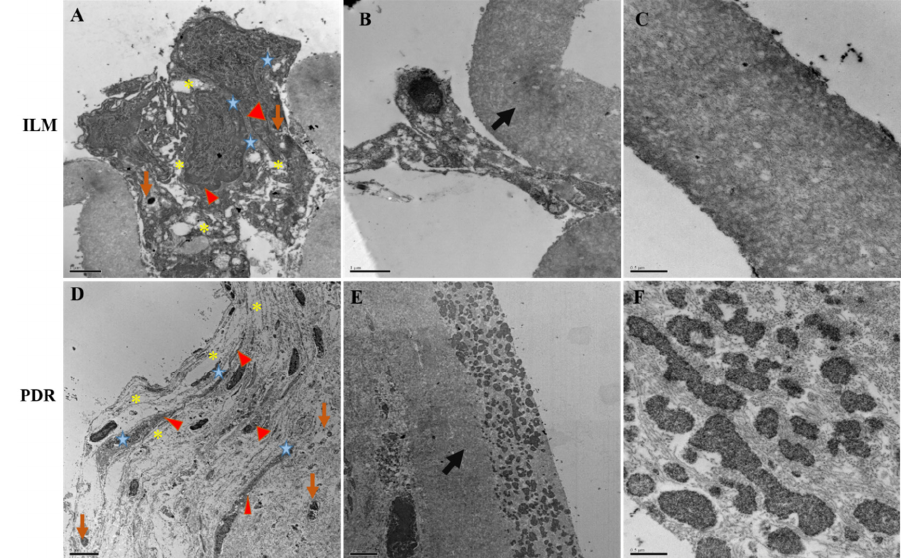
Figure 2. Transmission electron microscopy images of fibrocellular membranes from; ( A – C ); macular hole, and ( D – E ); proliferative diabetic retinopathy membrane showing the presence of astrocytes, Müller glia processes and microglia. The cell body of a Müller cell can be identified by its nucleus and dark cytoplasm (red color filled triangular shape). An astroglial cell process with flattened intermediate filaments (yellow colored asterisk) can be observed next to the Müller cell. The microglia can be seen with round shaped dark cell bodies (brown arrow) and glial cells processes with skyblue star shaped structure. ( B , E ) show collagenous fibrils of membrane indicated by black arrow and; ( C , F ) show their corresponding magnified